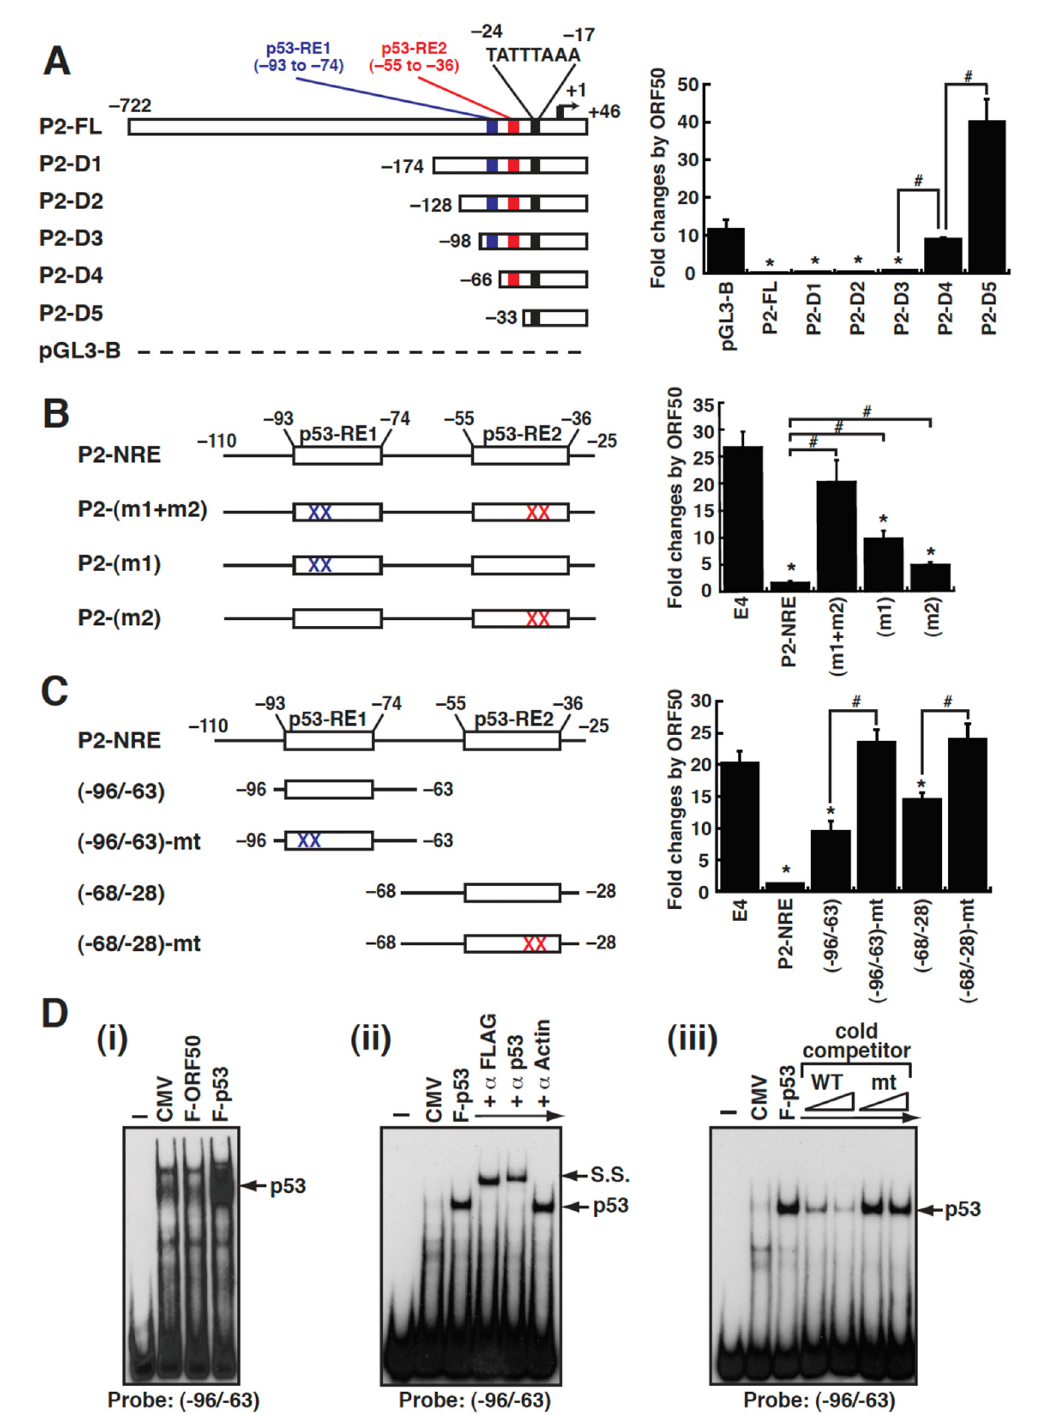
Figure 7. The p53-responsive elements in the P2 promoter of the MDM2 gene are critically required for the ORF50-mediated repression. ( A ) Deletion analysis of the MDM2 P2 promoter. The reporter constructs with the P2 promoter region from –722 to +46 (P2-FL) and its 5 ′ deletions are shown in the diagram (left panel). Notably, the P2 promoter contains a TATA-like box located between –24 to –17 and two p53-responsive elements (p53-RE1 and p53-RE2) located from –93 to –74 and from –55 to –36, respectively. Thirty hours after cotransfection, the fold change of the indicated reporter constructs in responding to ORF50 in 293T cells was determined by luciferase reporter assays (right panel). *, p < 0.05, compared to pGL3-Basic; #, p < 0.05, compared to the indicated reporter constructs (n = 3). ( B ) Point mutational analysis of the P2(–110/–25) promoter element. The left diagram shows the P2(–110/–25) promoter element (or referred to as P2-NRE) and its mutated elements that contain point mutations at the p53-RE1 or p53-RE2 motif or both motifs. These P2 promoter elements in